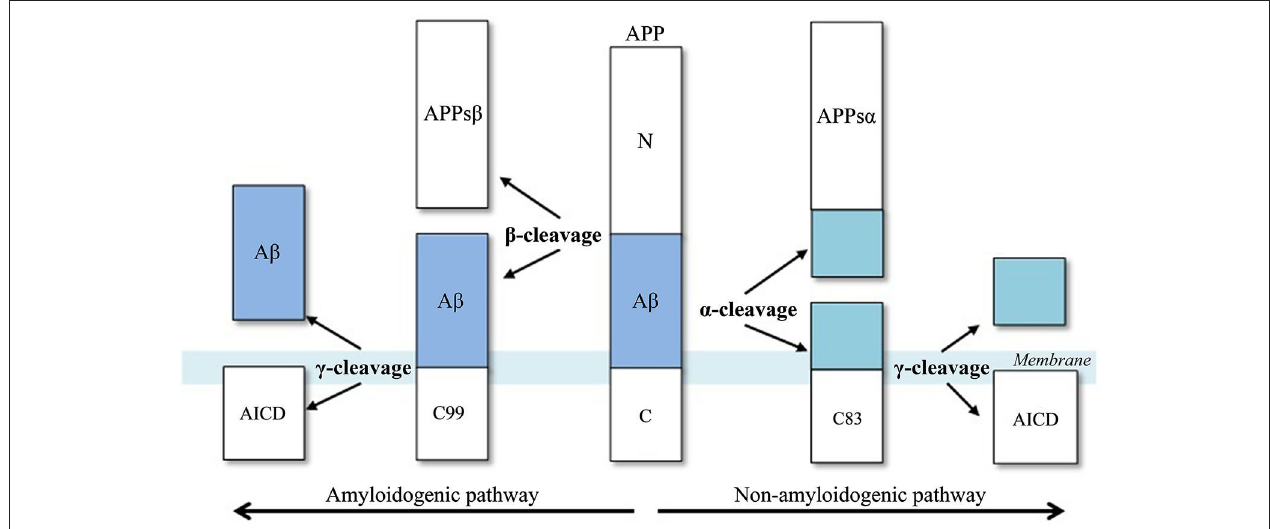
FIGURE 2 | A β -peptide biosynthesis, adapted from Cole and Vassar (2007). APP is sequentially cleaved by BACE1 ( β -secretase) and γ -secretase to generate A β . A β formation is prevented by the activities of α -secretase, which cleaves APP to generate the secreted ectodomain, APPs α and membrane bound fragment,